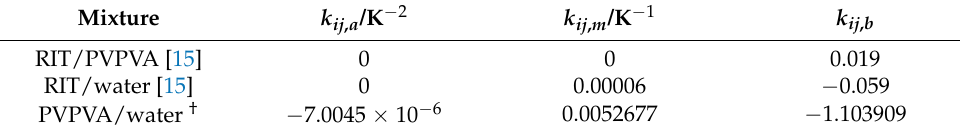
Table 5. PC-SAFT interaction parameters for mixtures of RIT, PVPVA, and water.